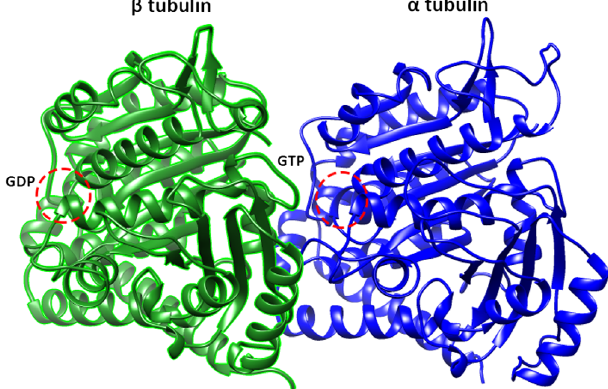
Figure 4. Modelled structure of the polymerized Echinococcus